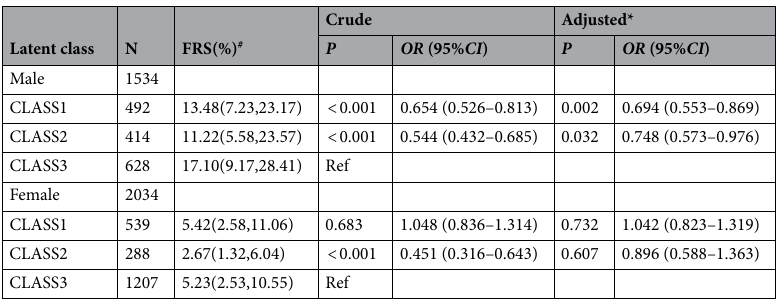
Table 5. FRS among different PA types and associations of PA types and the risk of CVD S . *Adjusted for education, work, drinking, BMI, dyslipidemia, central obesity, and overweight/obesity; # median (25th percentile, 75th